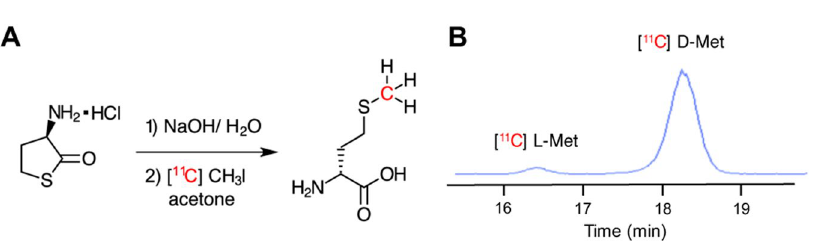
Figure 2. In vitro accumulation of 14 C D-amino acids in E. coli and S. aureus . ( A ) Panel of 14 C amino acids studied for relative uptake. ( B ) Dedicated 14 C D-Met study in E. coli and S. aureus including incubation with heat-killed organisms and in the presence of 1 mM unlabeled D-methionine.